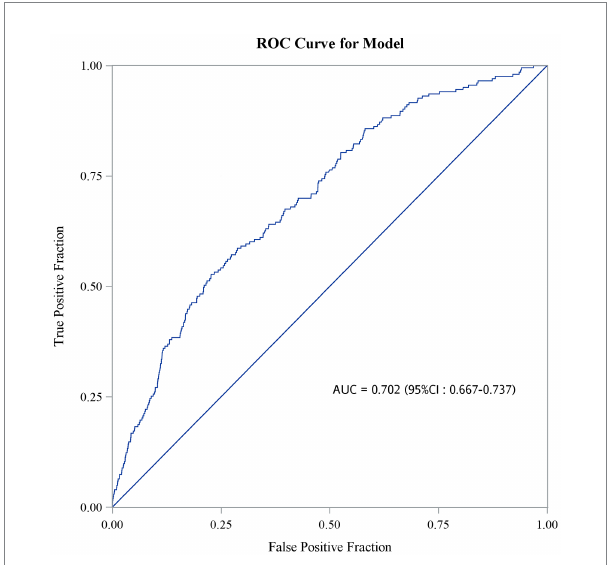
FIGURE 3 Discrimination ability of models predicting the occurrence of 180- day